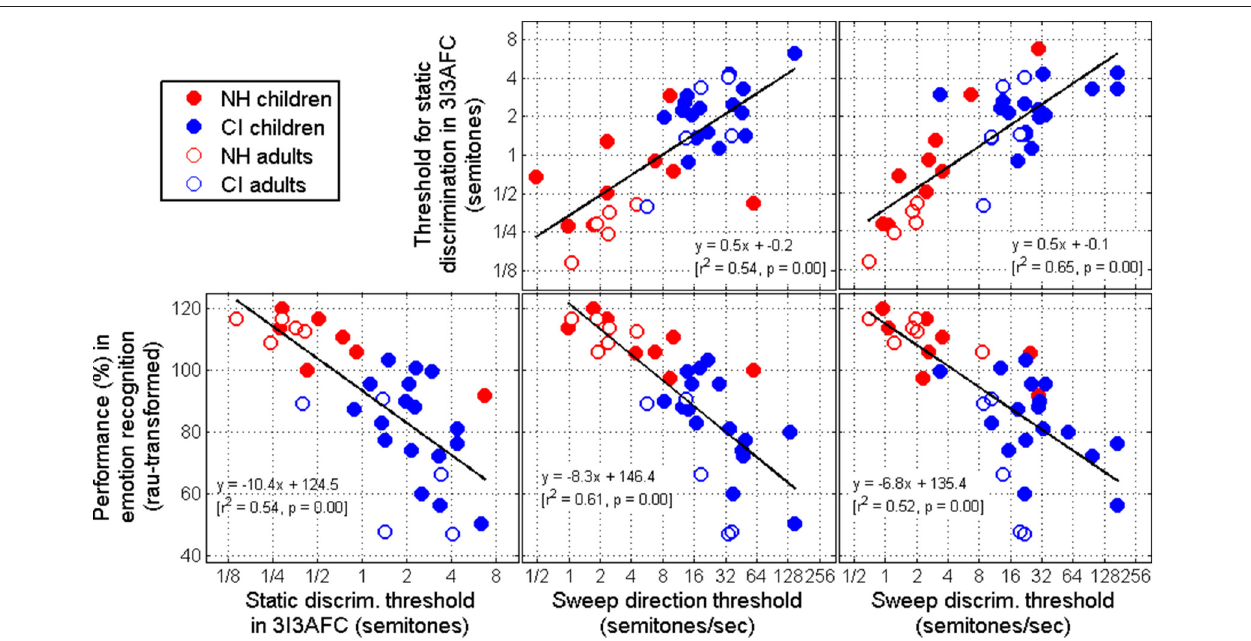
FIGURE 7 | (Top) Correlations between thresholds obtained in a 3I-3AFC task of static F0 discrimination with sweep thresholds. (Bottom) Correlations between static and dynamic F0 thresholds with performance in a task of voice emotion recognition. All cases are significant, and sweep direction thresholds hold the most predictive